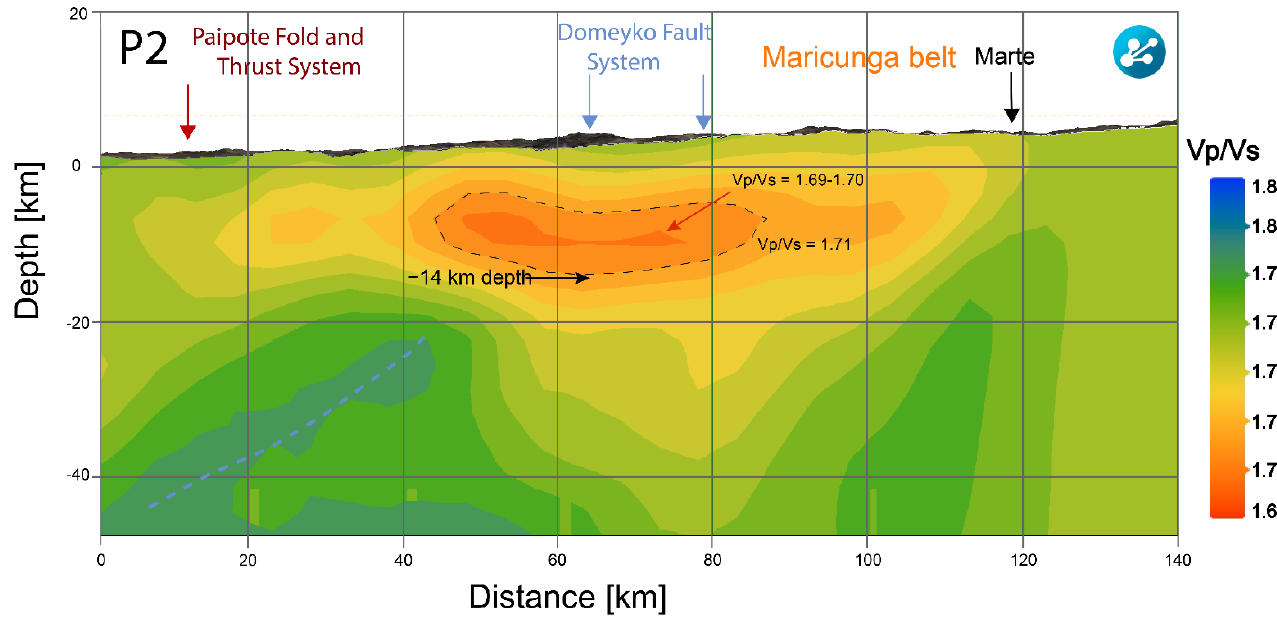
Figure 5. Cross section of the Vp/Vs model (with color intervals of 0.01) passing through the Marte deposit (27°10 ′ ) (see Figure 1). The locations of the Paipote Fold and Thrust System and the Domeyko Fault Systems are marked with red and light blue arrows, respectively. The location of the Marte mine is marked with a black arrow. The location of the MB is marked with red letters. Light blue dashed line represents a possible deep projection of the Domeyko Fault System.